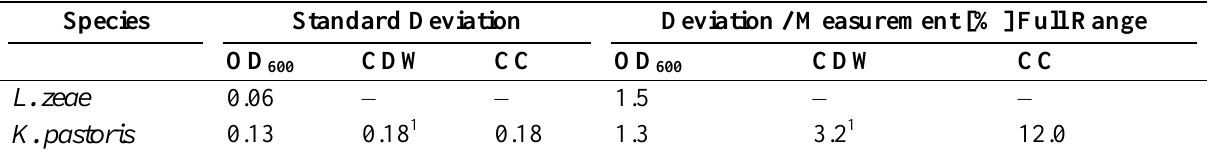
Table 4 . Standard deviation of the offline measurement results. CDW in g·L −1 ,